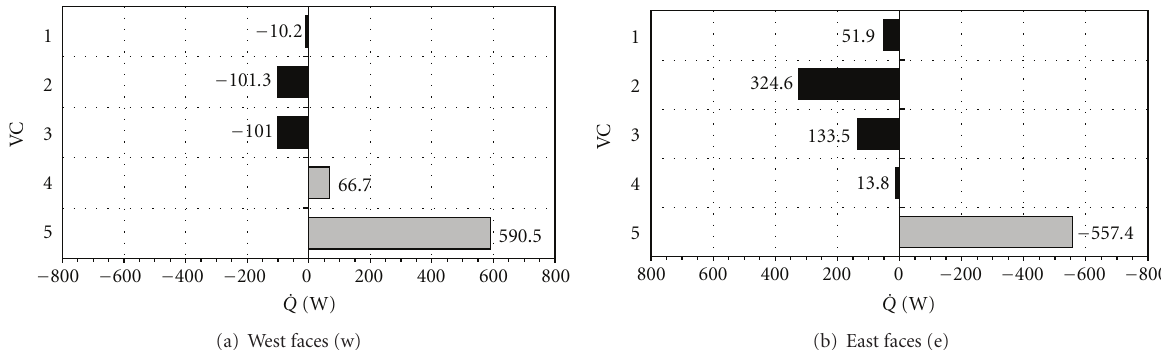
Figure 12: Heat transfer predictions across East (exterior border) and West (interior border) of air curtain control volumes, per unit